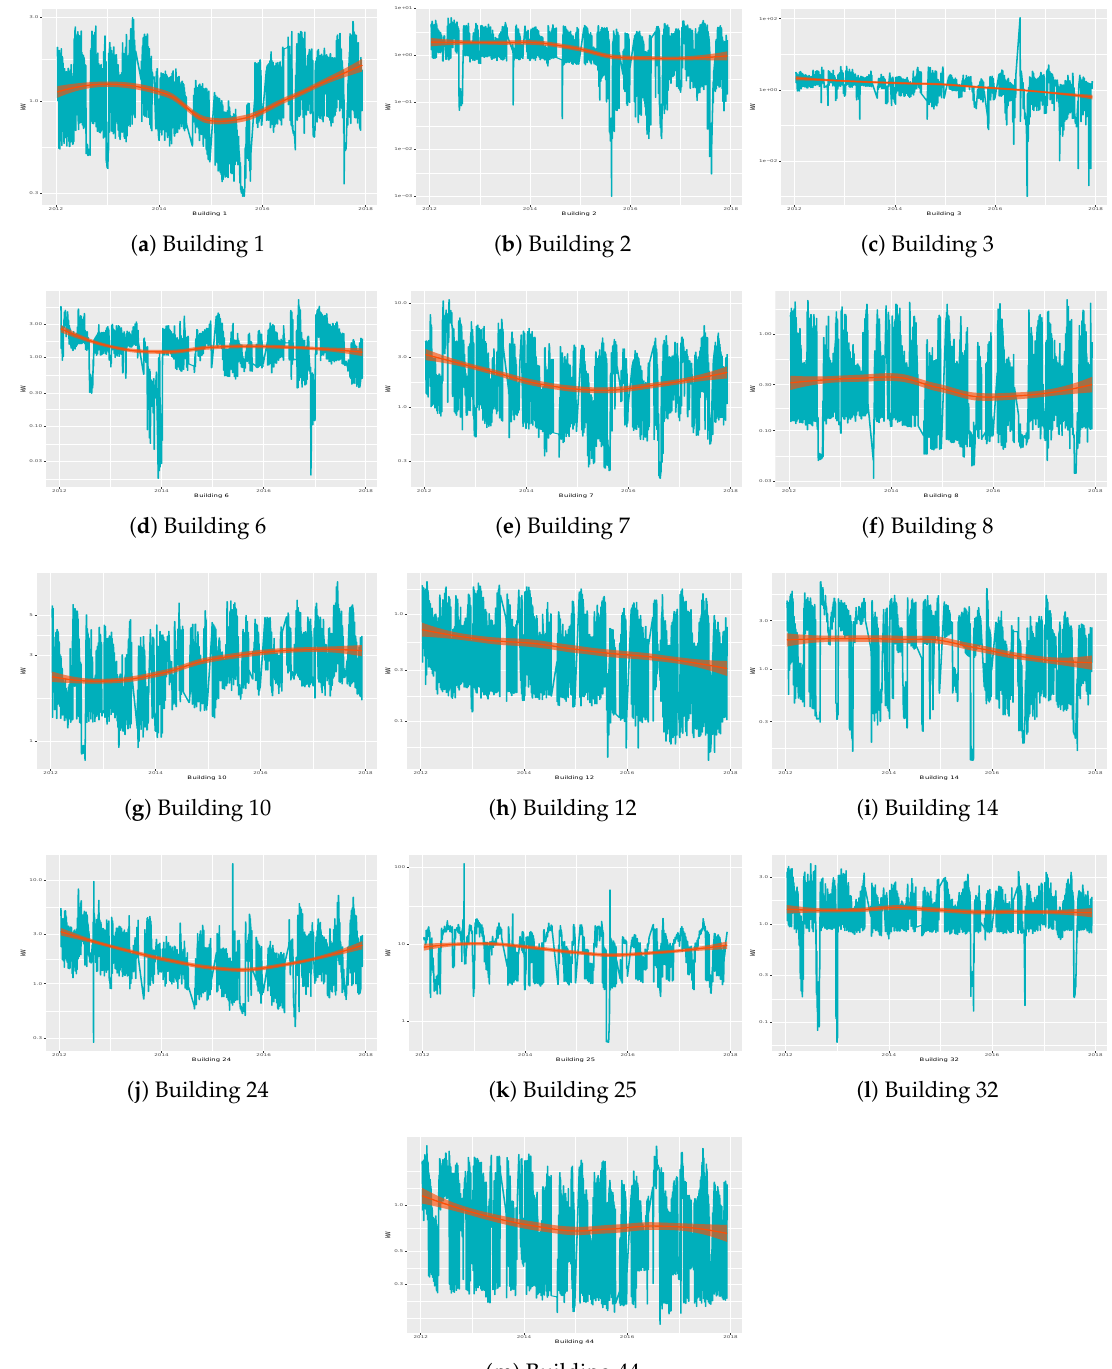
Figure 1. Graphical representation of the time series of all the buildings. The values are shown in logarithmic